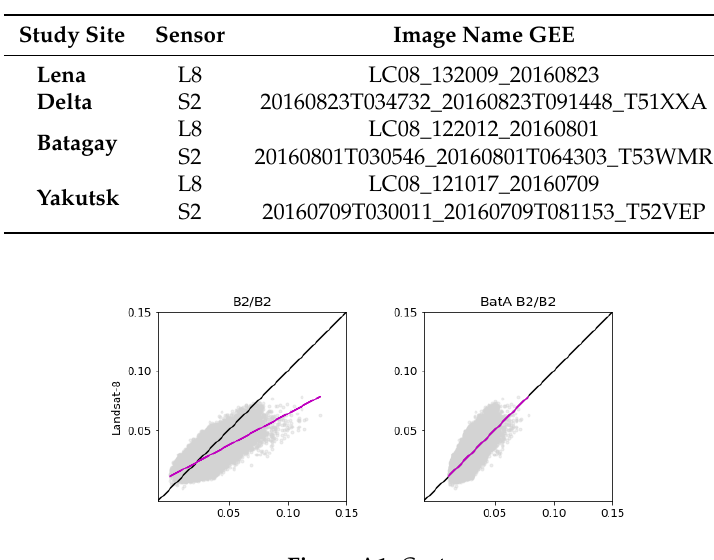
Table A1. The selected same-day images in Google Earth Engine (GEE) after data filtering for the three study